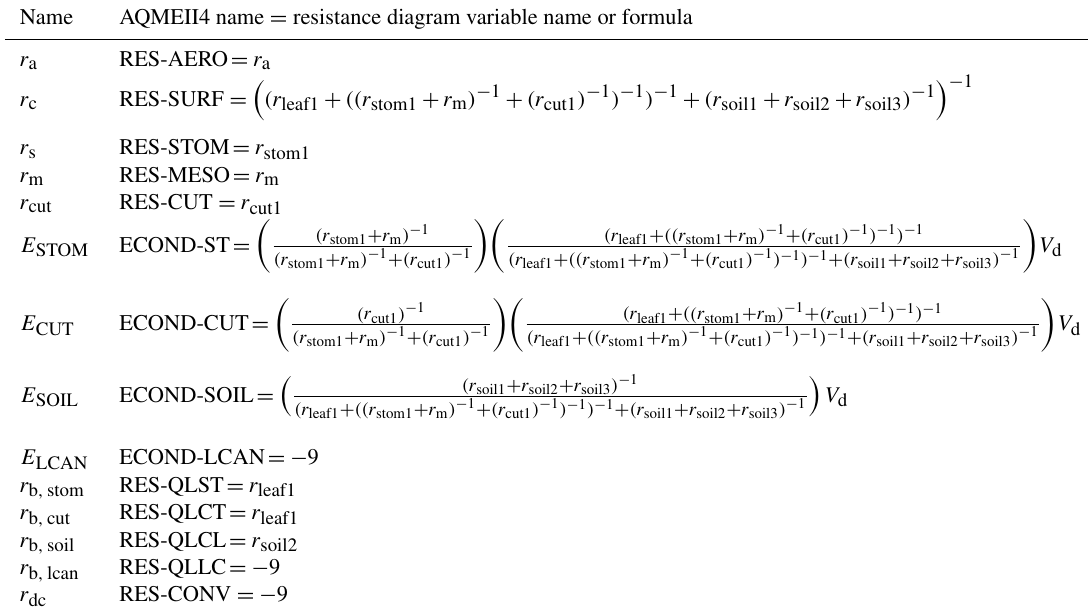
Table 5. AQMEII4 dry deposition diagnostic variables for gas-phase species corresponding to the resistance framework of Fig. 2a. Name